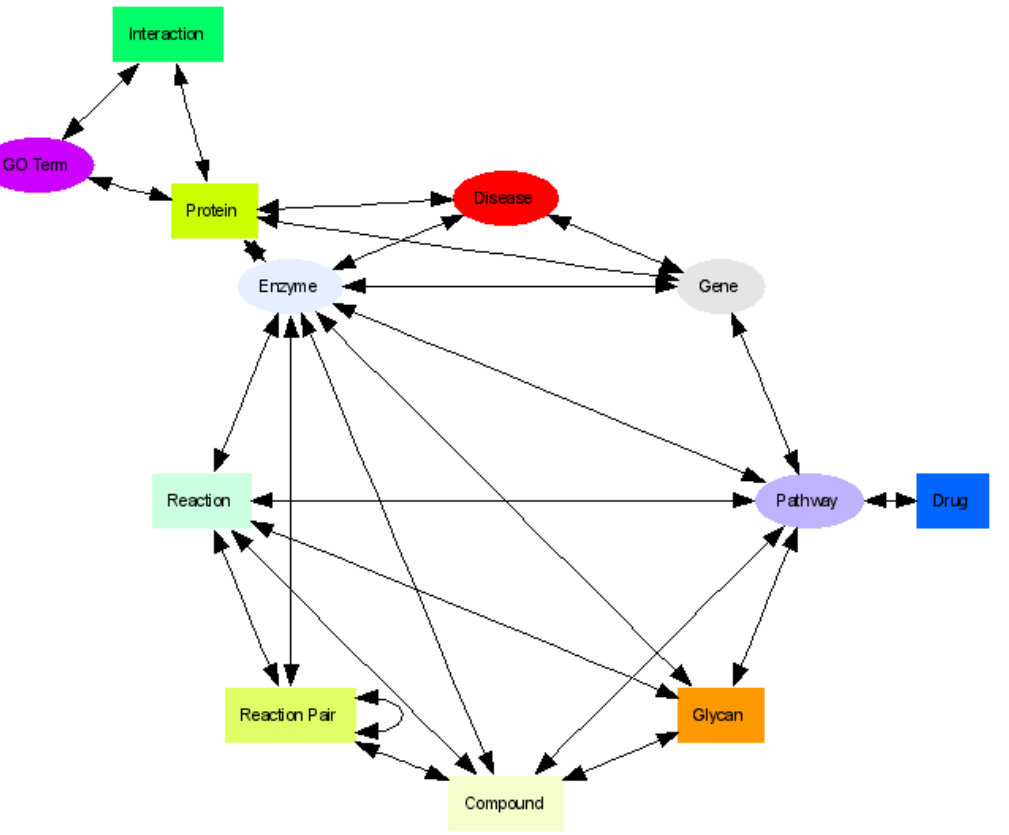
Figure 2: Schematic representation of the relationships between the different biological aspects (domains) within the integrated data of